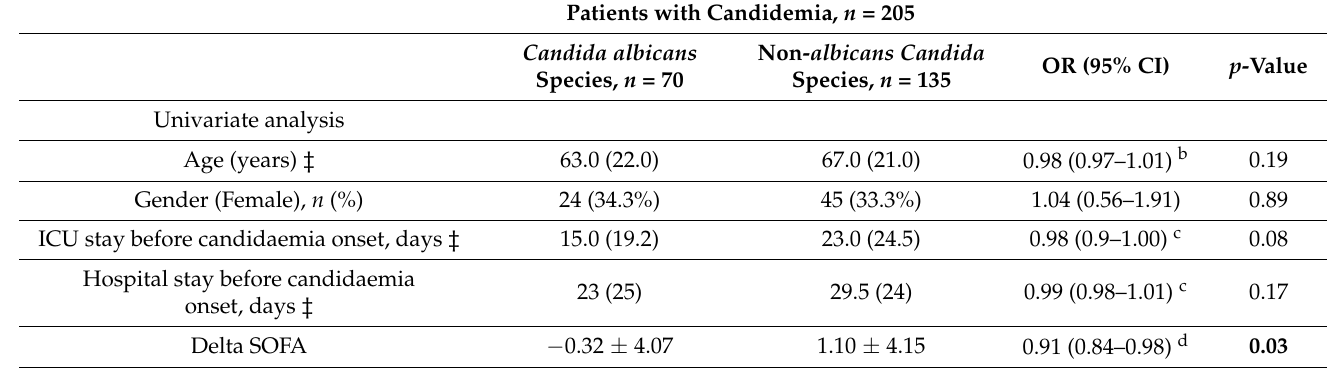
Table 3. Factors associated with candidemia development due to Candida albicans versus non- albicans Candida species in the overall study population: univariate and multivariate models. OR (95% CI) takes non- albicans Candida as the reference